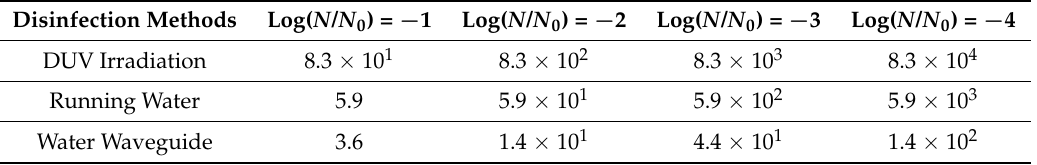
Table 1. Time requirements to obtain the 1-Log to 4-Log reductions by DUV light, running water, and water-waveguide disinfection methods for S. warneri . The unit used here is